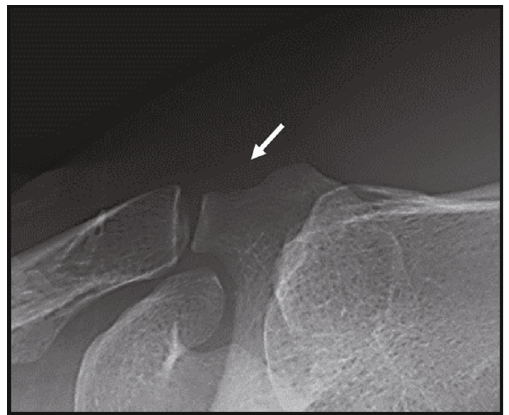
Figure 3: Plain radiograph with the arm in an elevated position showing the disappearance of calci fi